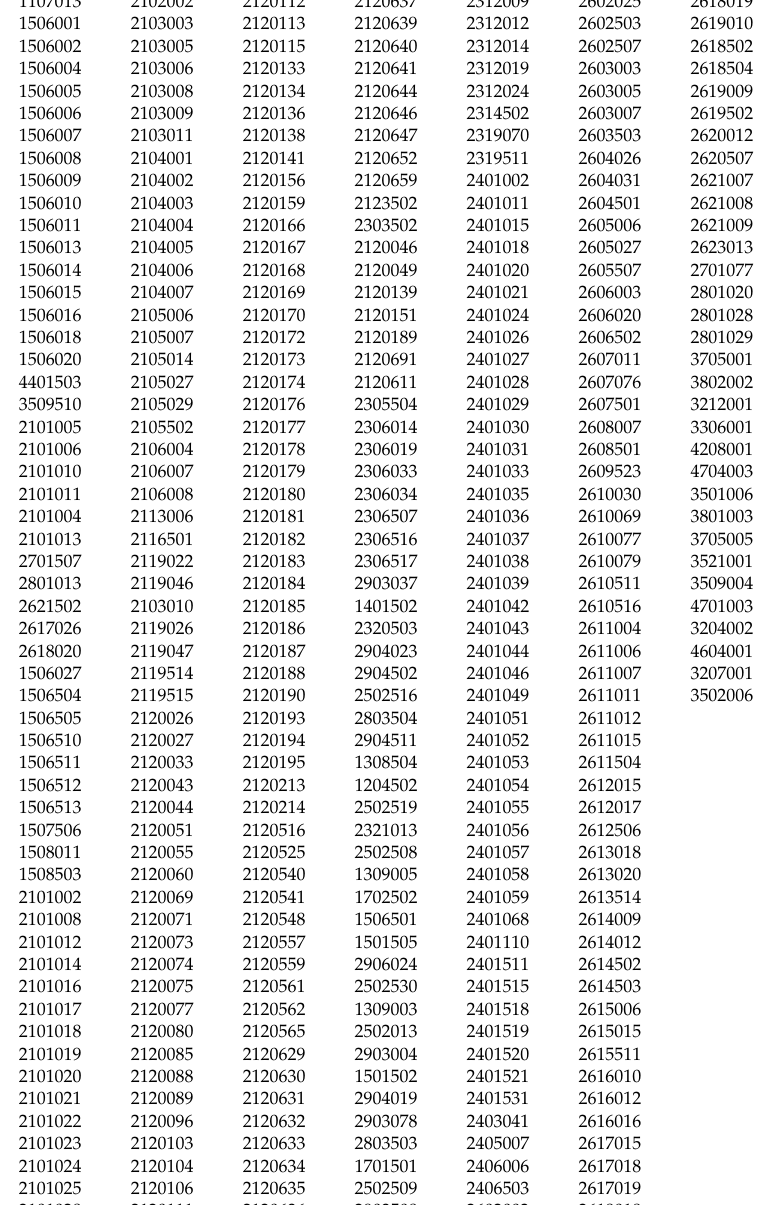
Table A1. Stations of Maximum Rainfall Accumulated in 24